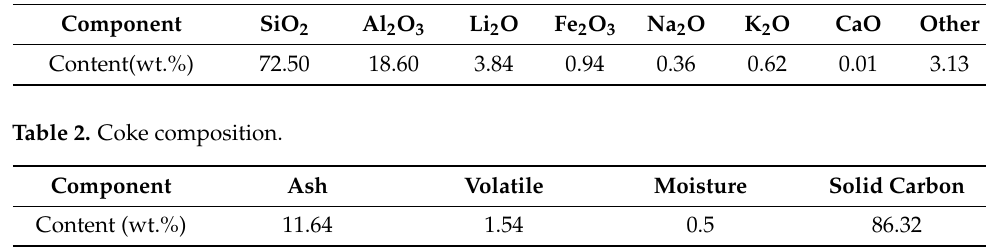
Figure 1. XRD pattern of spodumene ore. Table 1. Spodumene ore composition.